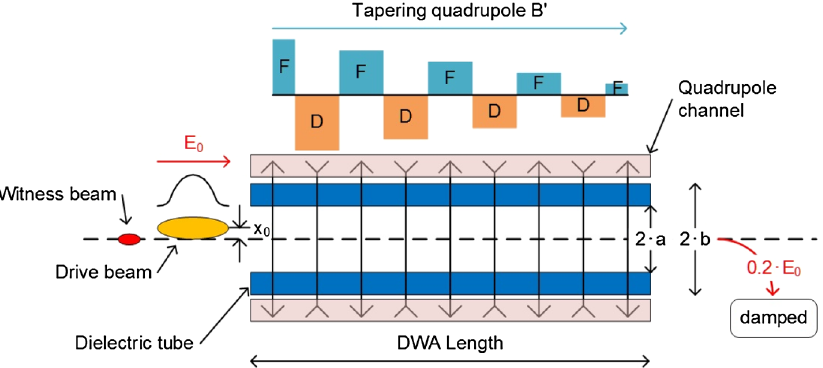
FIG. 1. Schematic of a DWA linac surrounded by a FODO lattice. The quadrupole field gradient B 0 is tapered to match the energy loss of the drive bunch along the linac. The final energy of the drive bunch at the end of the structure is 20% of its initial